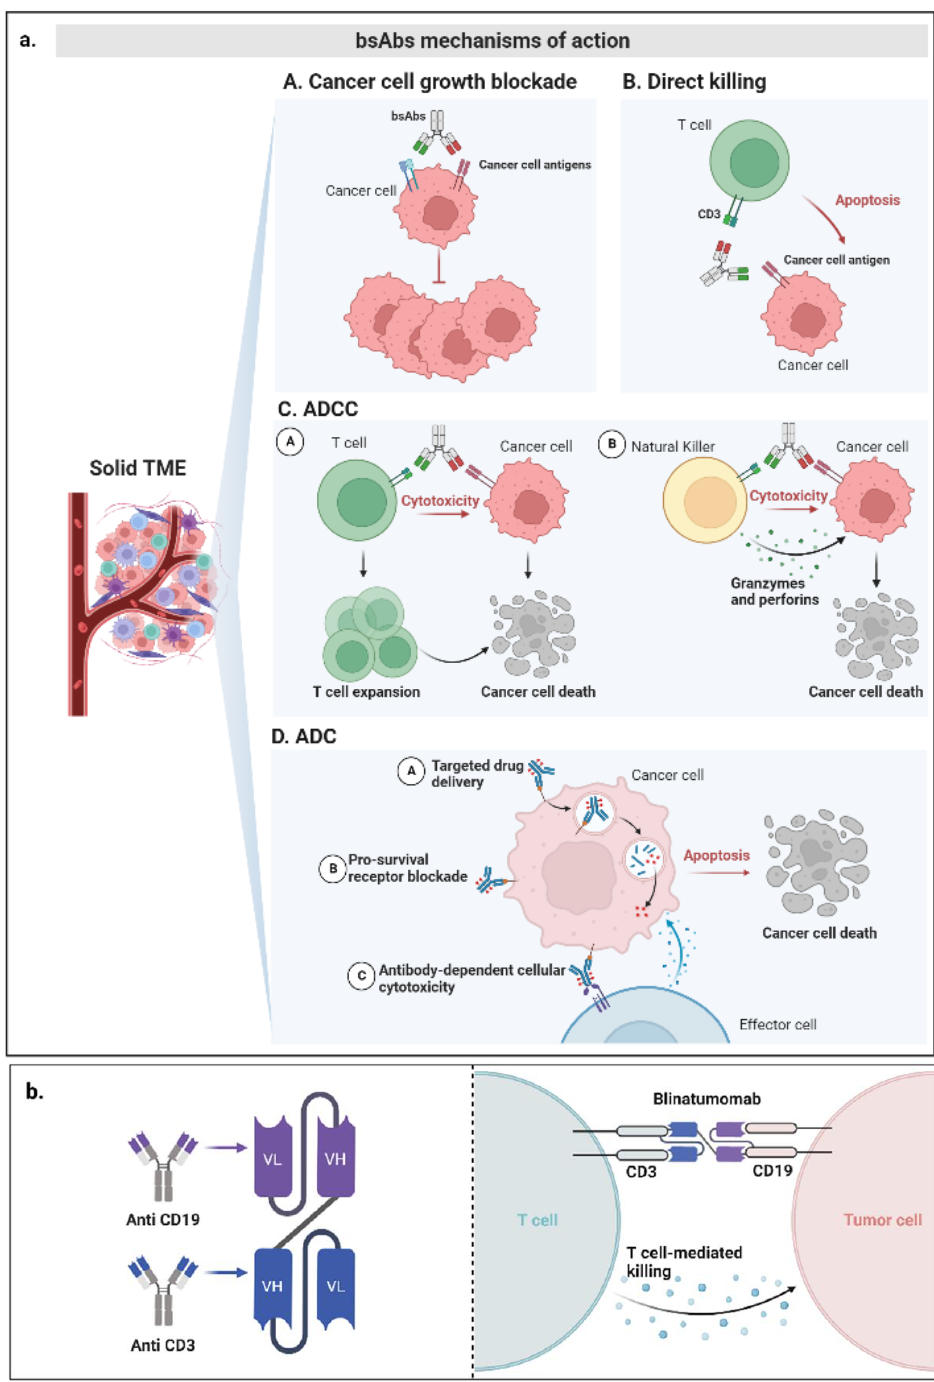
Figure 3. Targeting effector cells with bsAbs for cancer therapy. ( a ) Illustration of bsAb mechanisms of action. Binding of bsAbs to their targets initiates downstream signaling pathway activation that results in ( A ) cancer cell growth blockade, ( B ) cancer cell apoptosis induction by cytotoxic T cells, ( C ) cancer cell apoptosis induction by ADCC (Antibody-Dependent Cell Cytotoxicity) followed by T- cell expansion (panel on the left) as well as by granzyme and perforin release from Natural Killer cells (panel on the right), ( D ) cancer cell apoptosis induction by ADC (Antibody–Drug Conjugated) which mediates target drug delivery (up illustration), pro-survival receptor blockade (middle illustration) and ADCC (bottom illustration). ( b ) Structure and mechanism of action of Blinatumomab. TME: Tumor